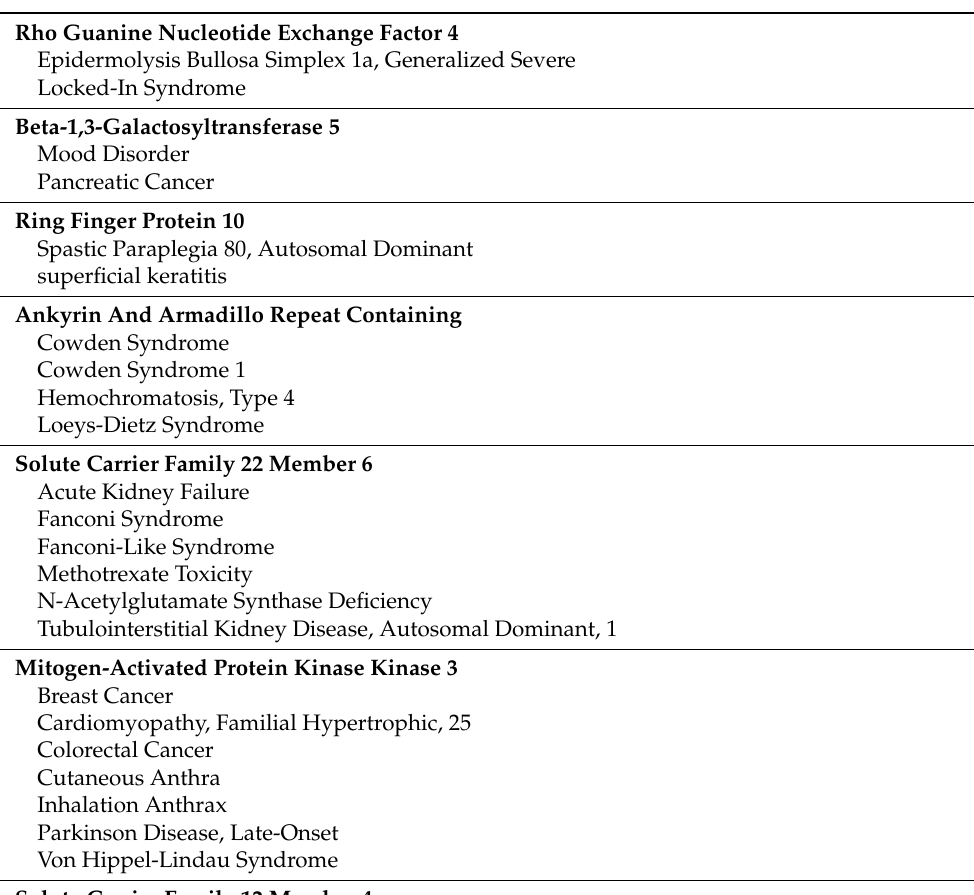
Table A1. Cont. Rho Guanine Nucleotide Exchange Factor